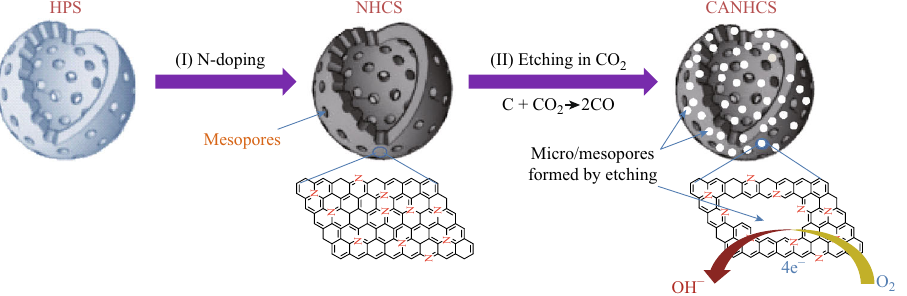
Fig. 1 Scheme for the synthesis of CANHCS with hollow macroporous core and hierarchical micro-mesopores as highly active metal-free electrocatalysts with improved activity for the ORR via a direct four-electron reaction pathway. (I) N doping of HPS by thermal treatment in NH 3 and (II) etching NHCS via the reaction with CO 2 at high temperature to form micro-mesopores within the shells